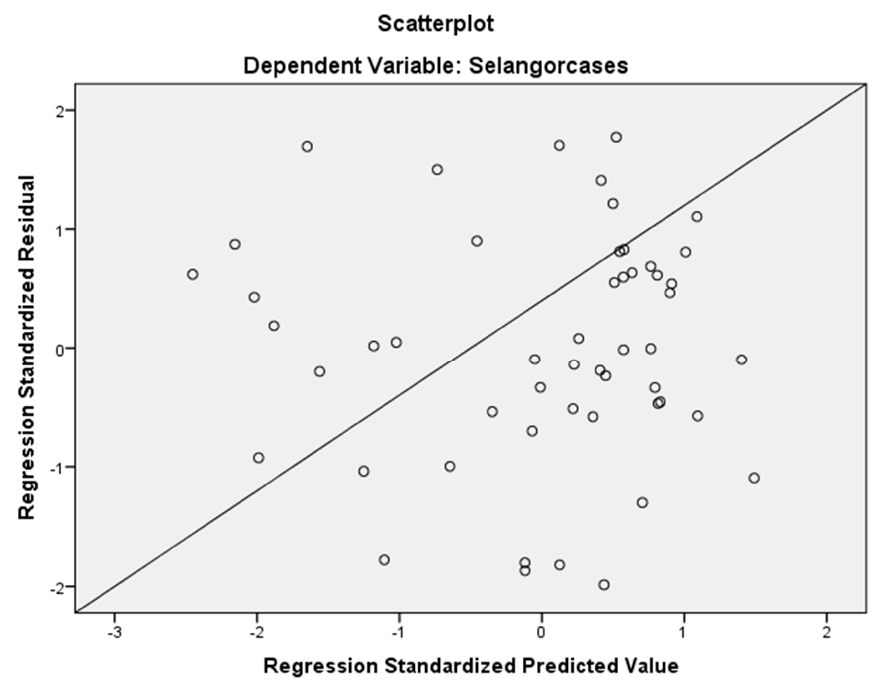
Figure A4. Dengue case in Selangor, 2011 to 2019.